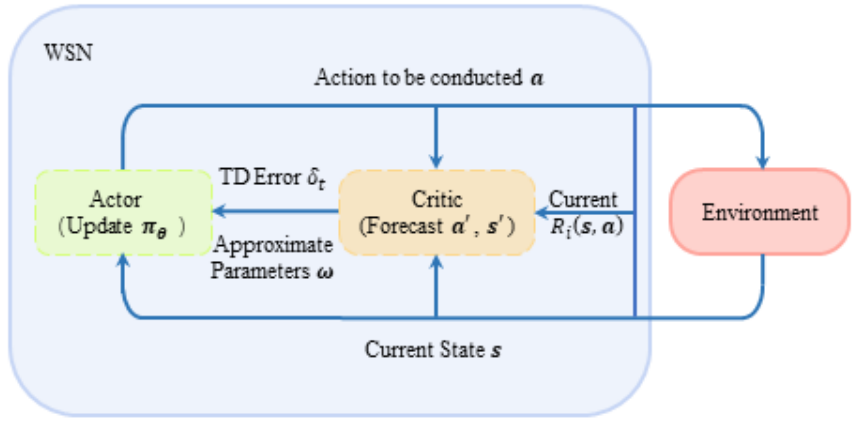
Figure 5. The diagram of DAJA’s structure applied to multi-agent system.